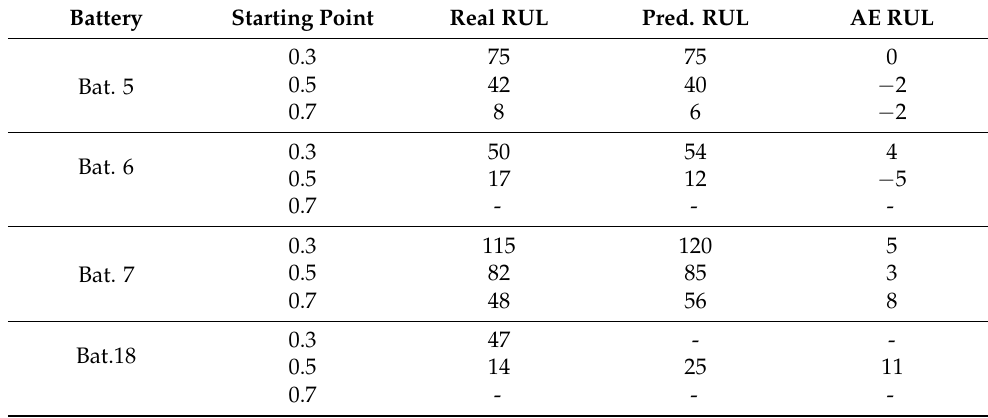
Table 5. The RUL prediction results with different starting points Battery